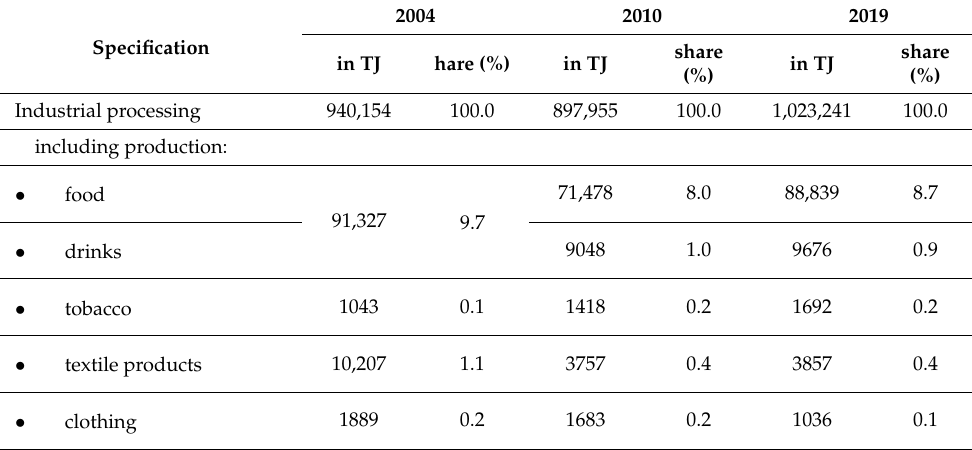
Table 1. Direct energy consumption of industrial processing by section and